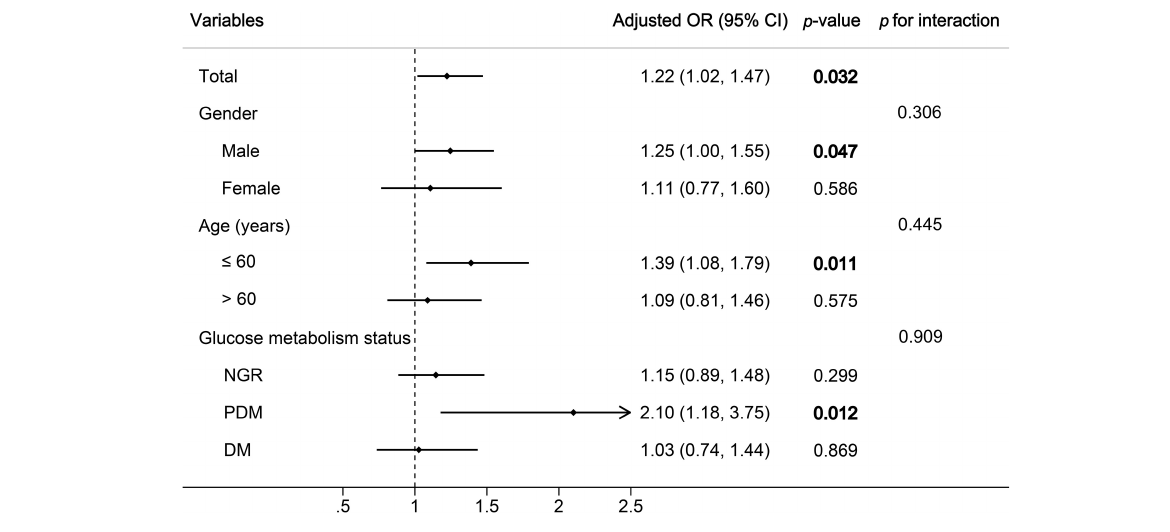
TABLE 6 Comparison of the predictive value of the TG/HDL-C ratio, TyG index, and METS-IR for predicting the presence of CAD. Variables Sensitivity (%) Specificity (%) Cutoff value AUC (95% CI) p -value Comparison of AUC